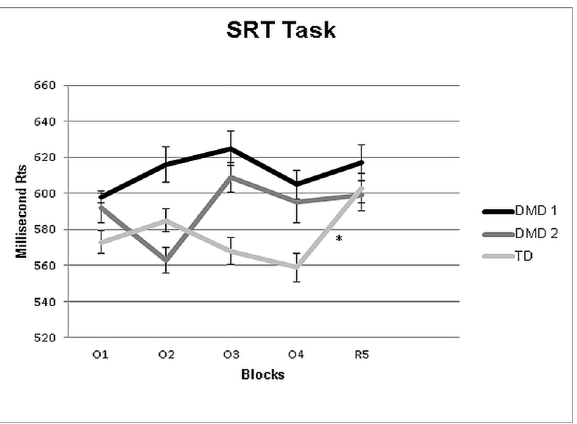
Fig 2. Average reaction times of correct responses of the three groups in all the five blocks of the SRTT. Vertical bars show standard deviation. * p < 0.05from the blocks.